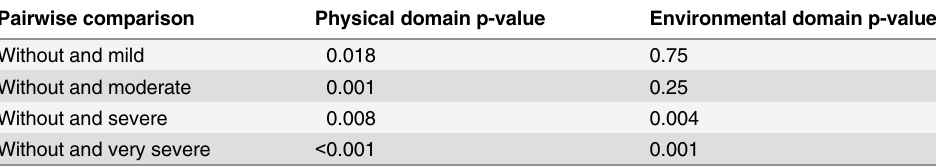
Table 3. Pairwise comparison of the SALSA categories by the physical and environmental